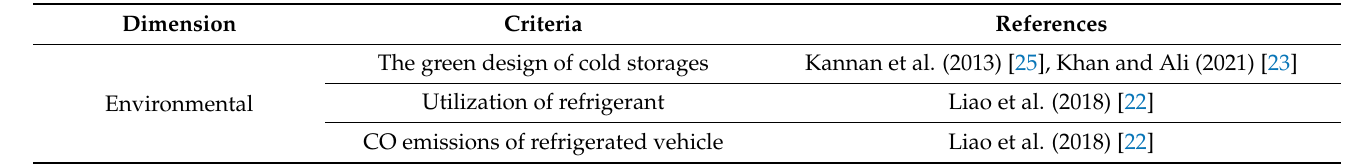
Table 1. Factors under consideration for the sustainability of cold chain logistics service providers. Dimension